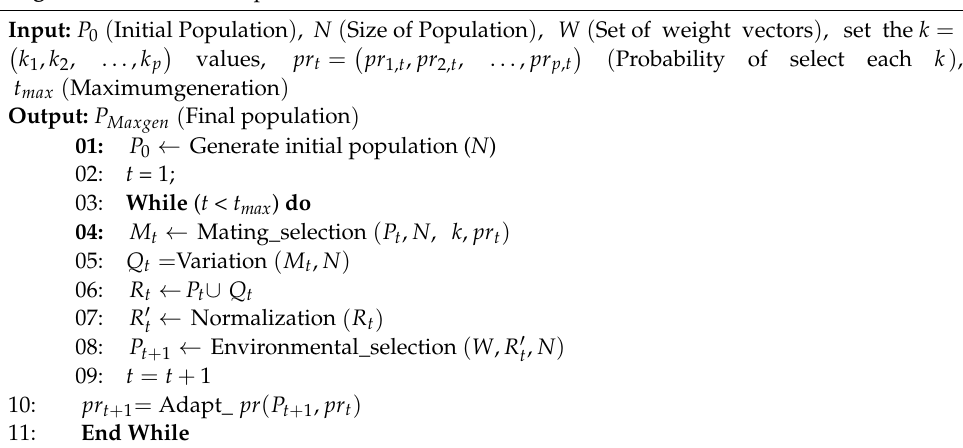
Algorithm 1: NSGA-III*